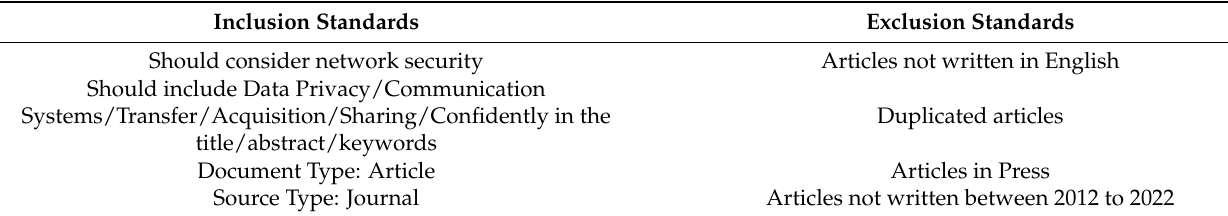
Table 1. Standards of inclusion and exclusion.